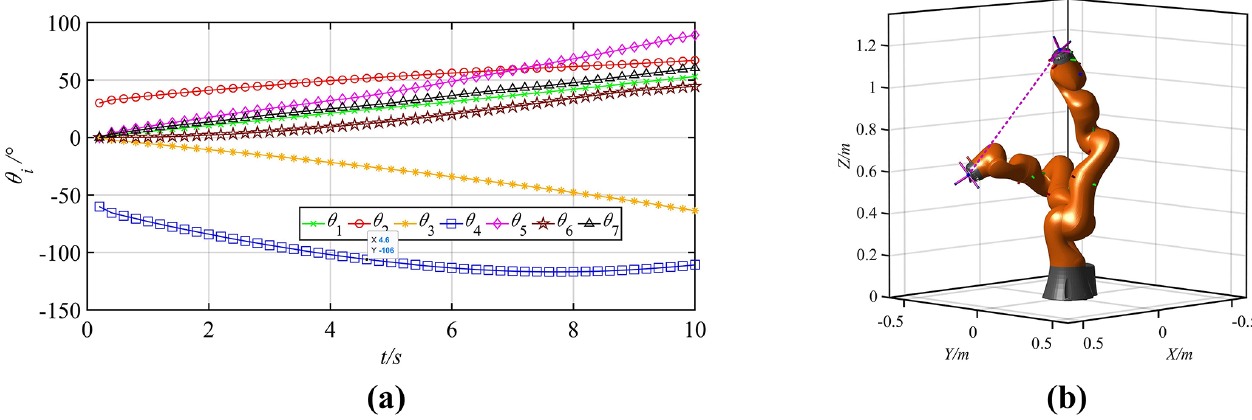
Figure 14. Motion curves of the joints and the manipulator ( k 1 = k 2 = k 3 = k 4 = k 5 = k 6 = k 7 = 1 . 0). (a) Joint motion curves. (b) Trajec- tory of the manipulator.